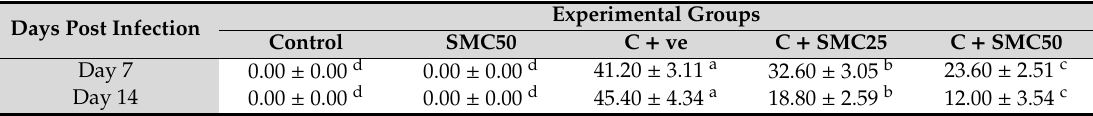
Table 1. The number of Cryptosporidium parvum oocysts shed in mice feces collected from di ff erent experimental groups at days 7 and 14 post-infection